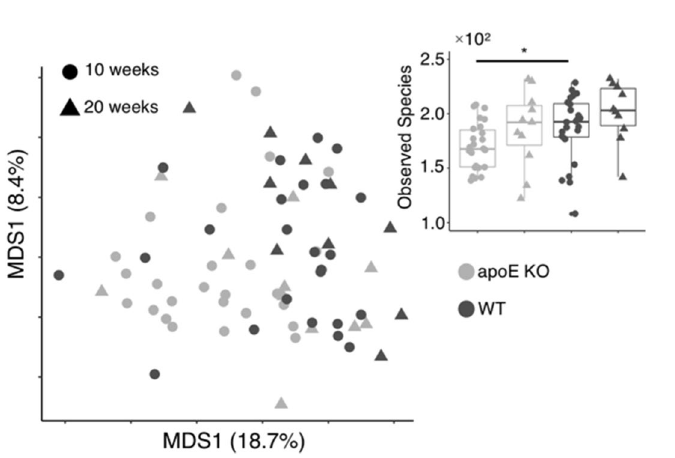
Figure 7. Amino acid transporters and sensors during the acute trial. mRNA expression of Sestrin2 ( A ), SLC38A9 ( B ), LAT1 ( C ), CD98 ( D ), and SNAT2 ( E ) in WT (dark bars) and Apoe KO (grey bars) mice at basal (WT n = 10, Apoe KO n = 8), 0.5 h (WT n = 9, Apoe KO n = 9) and 2 h (WT n = 8, Apoe KO n = 8) after whey protein feeding. Data were normalized to RPLP0 and expressed as fold change from WT basal and individual values are shown with bars indicating geometric means ± back-transformed SEM. * difference between time points, p < 0.05.